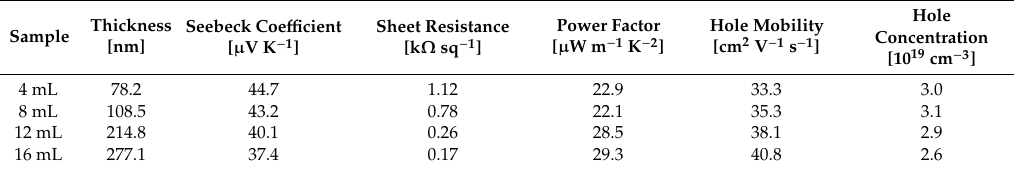
Table 1. Electronic and thermoelectric properties for ultrasonic-assisted liquid phase exfoliation (UALPE) multilayer graphene films of different thicknesses.